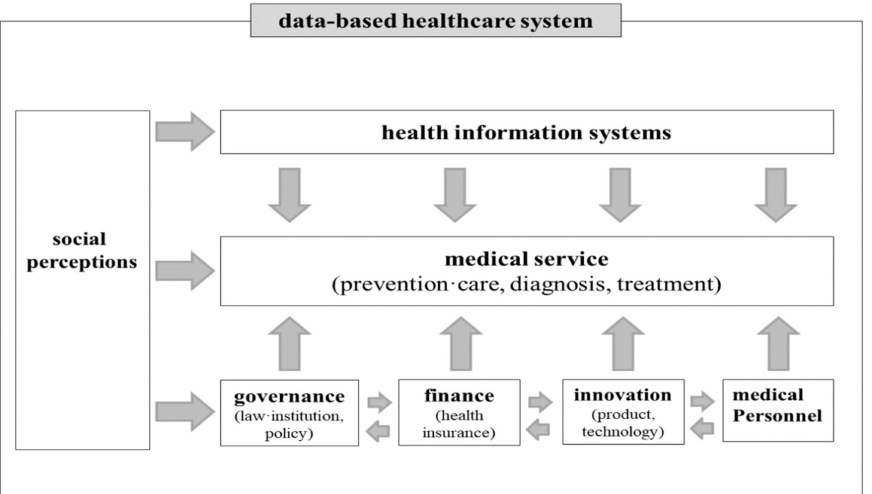
Figure 1. Data-based healthcare